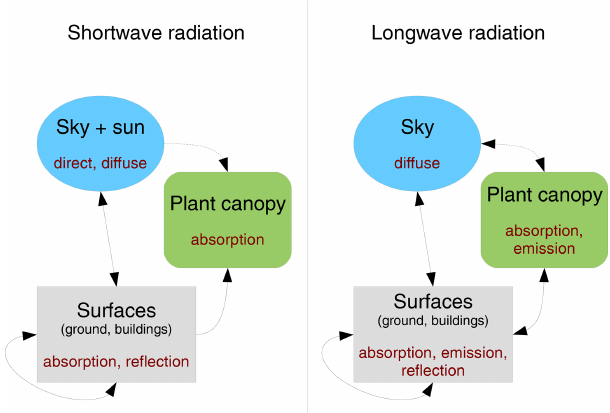
Figure 1. Radiative processes simulated by RTM version